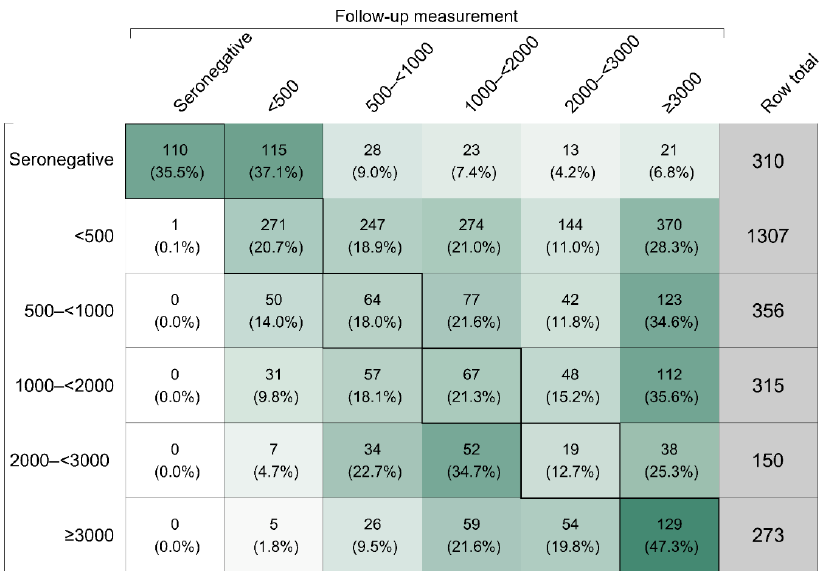
Figure 2. Shift of participants across categories of anti-S IgG antibody levels in Binding Antibody Units per milliliter between first and last available follow-up measurement between October 2021 and April 2022. Seronegativity corresponds to anti-S IgG levels < 7.1 Binding Antibody Units per milliliter. The intensity of the cell color reflects the row percentage of the cell. The diagonal of the matrix indicates the number (row percentage) of participants who remained in the same category of anti-S IgG antibody level between the first and last available follow-up measurement. The upper part of the matrix depicts the number (row percentage) of participants that were shifted to a higher category, i.e., they had an increase in anti-S IgG antibody levels between the first and last available follow-up measurements. The lower part of the matrix depicts the number (row percentage) of participants that were shifted to a lower category, i.e., they had a decrease in anti-S IgG antibody levels between the first and last available follow-up measurement. The analysis was restricted to participants with at least one follow-up measurement and involved data on 2711